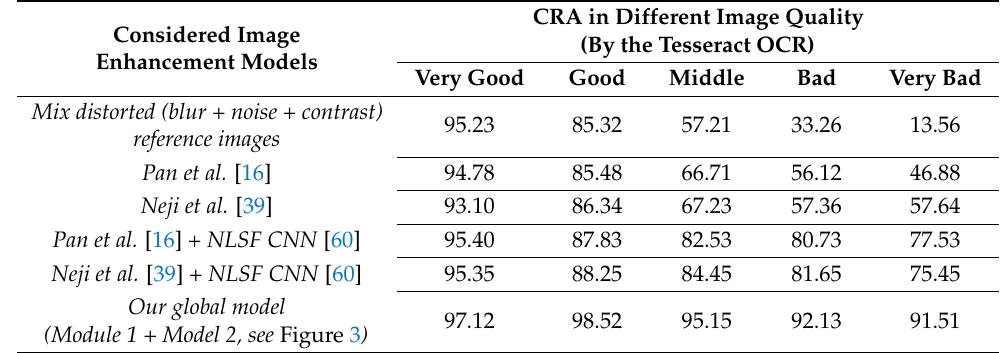
Table 5. The character recognition accuracy (CAR) was obtained for all enhanced images using our own dataset after testing the Tesseract OCR software [73] version 5.0.0. For each test, 100 images are used for testing each model considered here from our own dataset of real-world document images. CRA in Different Image Quality Considered Image (By the Tesseract OCR) Enhancement Models Very Good Good Middle Bad Very Bad Mix distorted (blur + noise + contrast) reference